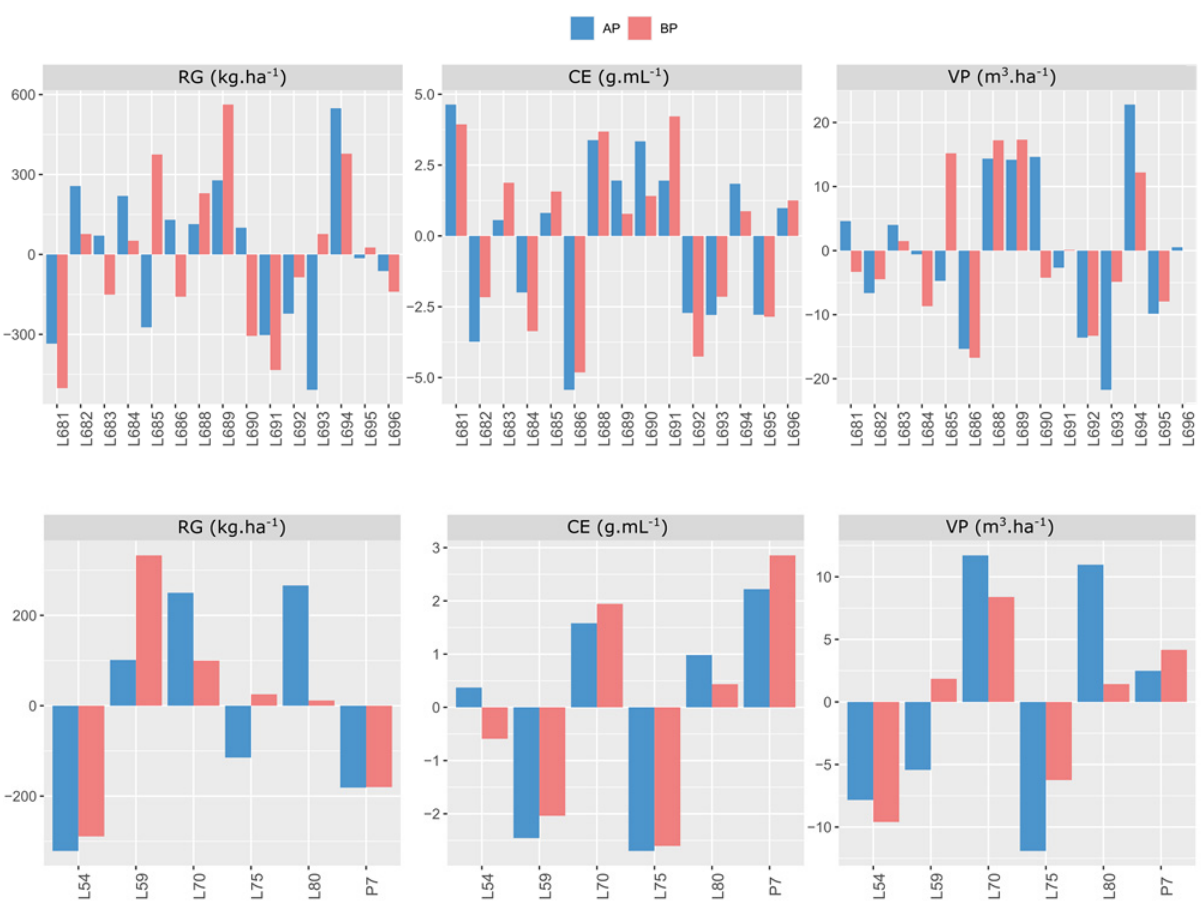
Figure 2. Estimates of general combining ability effects ( ĝ i ) for three traits evaluated in 21 popcorn parents in a partial diallel scheme in Itaocara. HP—high phosphorus level; LP—low phosphorus level; PE—popping expansion; GY—grain yield; and PV—popcorn expanded volume per hectare; ( − ) signal indicating negative values.